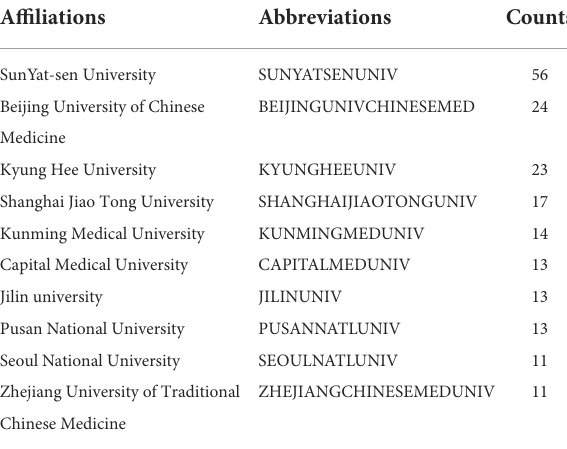
TABLE 3 Abbreviations and publications of the major participating